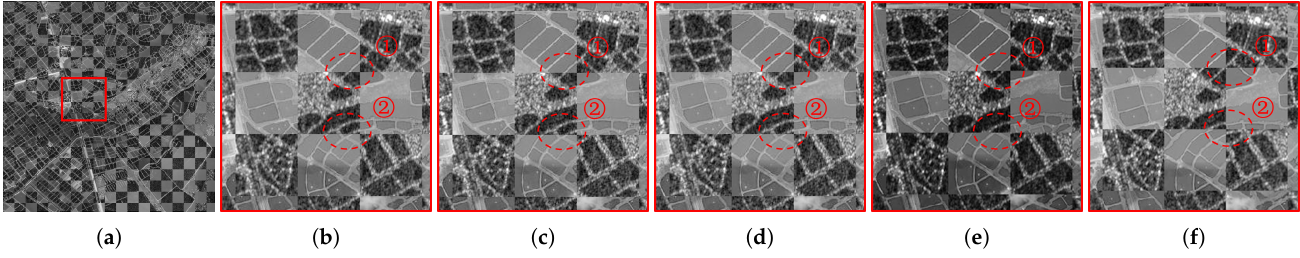
Figure 23. Checkboard mosaic image and enlarged sub-images of Pair F: ( a ) checkboard mosaic image of HOPES; ( b – f ) enlarged sub-images of HOPES, CFOG, HOPC, SAR-SIFT, OS-SIFT.